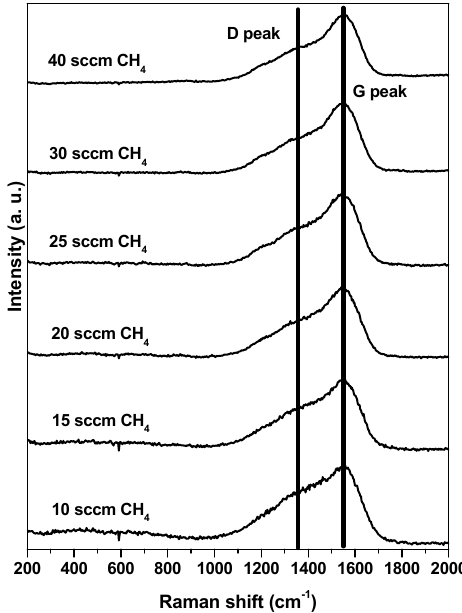
Figure 1. Raman spectra for all samples. For each sample, two measurements were acquired, and the results in the figure are the average of both.